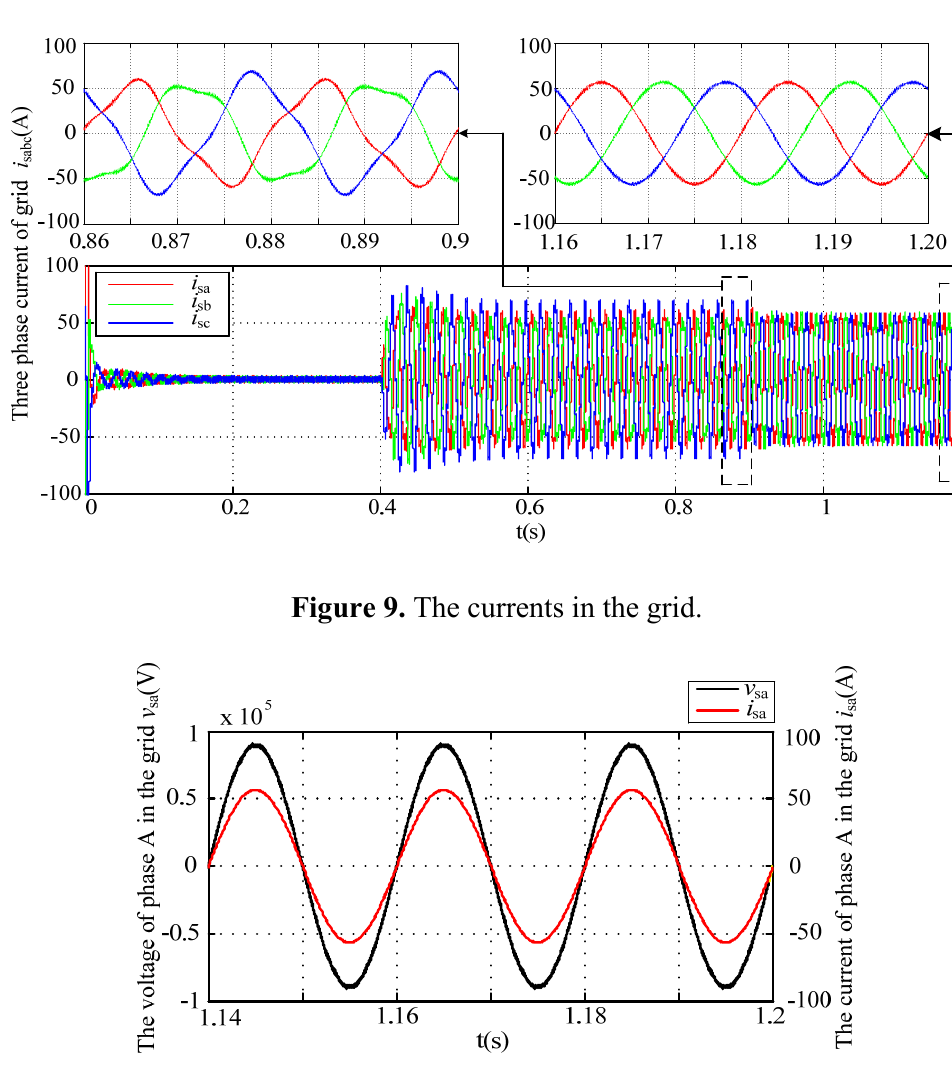
Figure 10. The voltage and current of phase A in the grid.